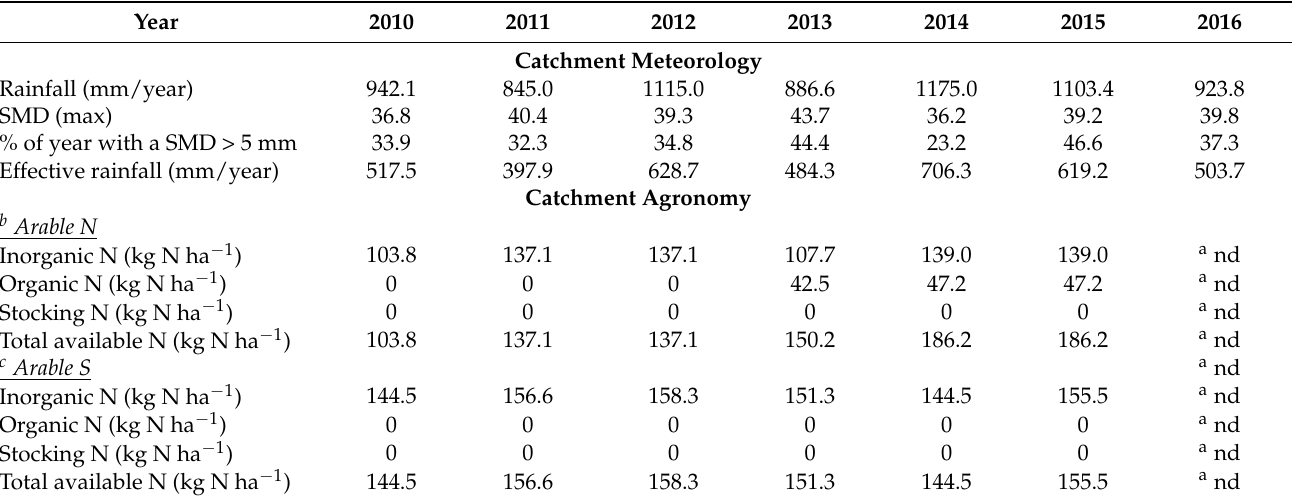
Table 7. Arable catchment annual totals (2010–2016) of rainfall and effective rainfall, maximum accumu- lated SMD and the percentage of each year with a SMD in excess of 5 mm. The chemical N, organic N, stocking N and total available N inputs to the land surface from 2010 to 2016 are also